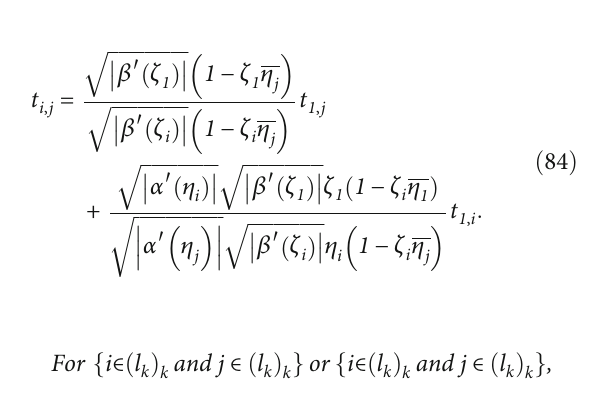
ffiffiffiffiffiffiffiffiffiffiffiffiffiffiffiffi (cid:12) β ′ ζ ð Þ (cid:12) 1 ffiffiffiffiffiffiffiffiffiffiffiffiffiffiffi (cid:12) β ′ ζ ð Þ (cid:12) i